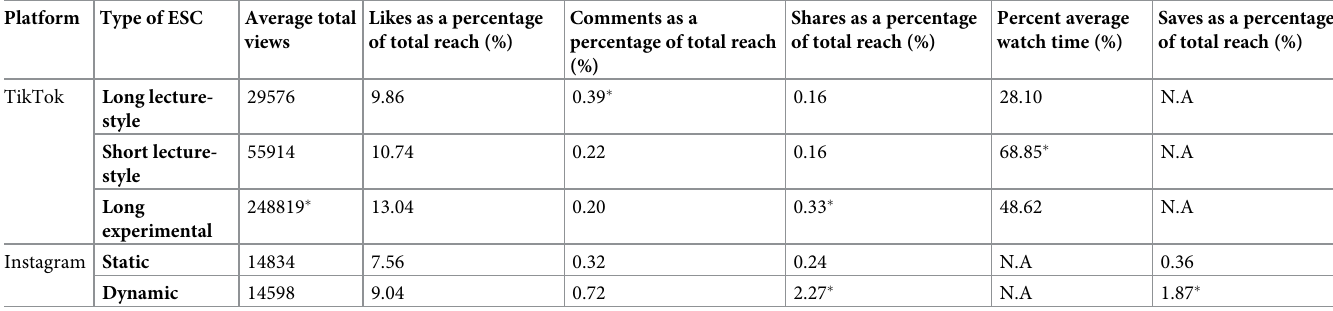
Table 1. Summary of data collected from the three styles of ESC posted to Instagram and TikTok. Platform Type of